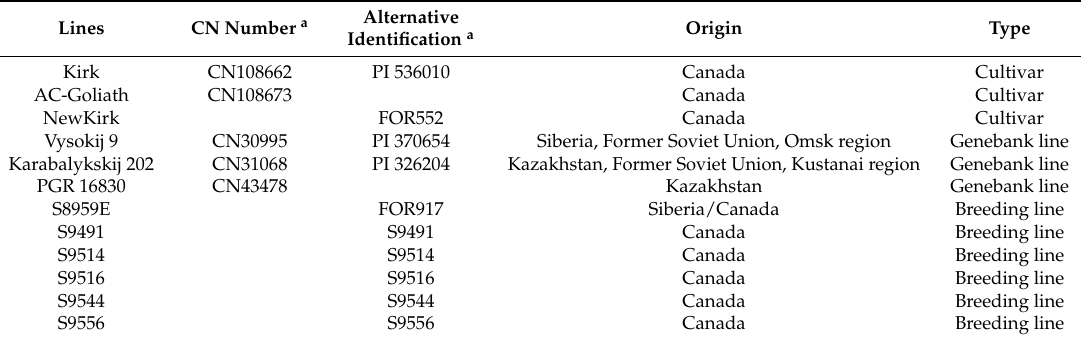
Table 1. List of the 12 crested wheatgrass ( A . cristatum ) lines used in the study.